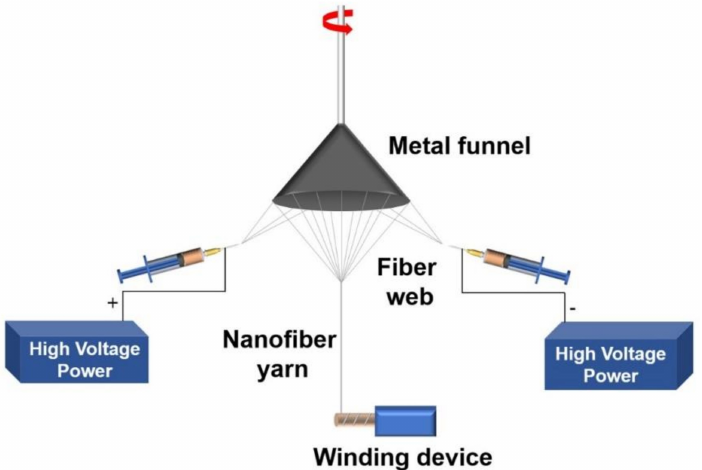
Figure 7. The illustration of core-sheath yarns endowed with suitable mechanical property for producing a fabric. The fiber web is drawn by an insulating rod placed in center of funnel, and then forms a fibrous cone which is twisted by rotating funnel to form continuous yarns